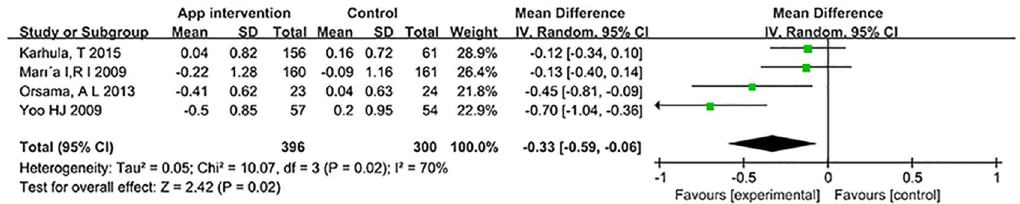
Fig 4. Forest plot for HbA1c < 8% at baseline